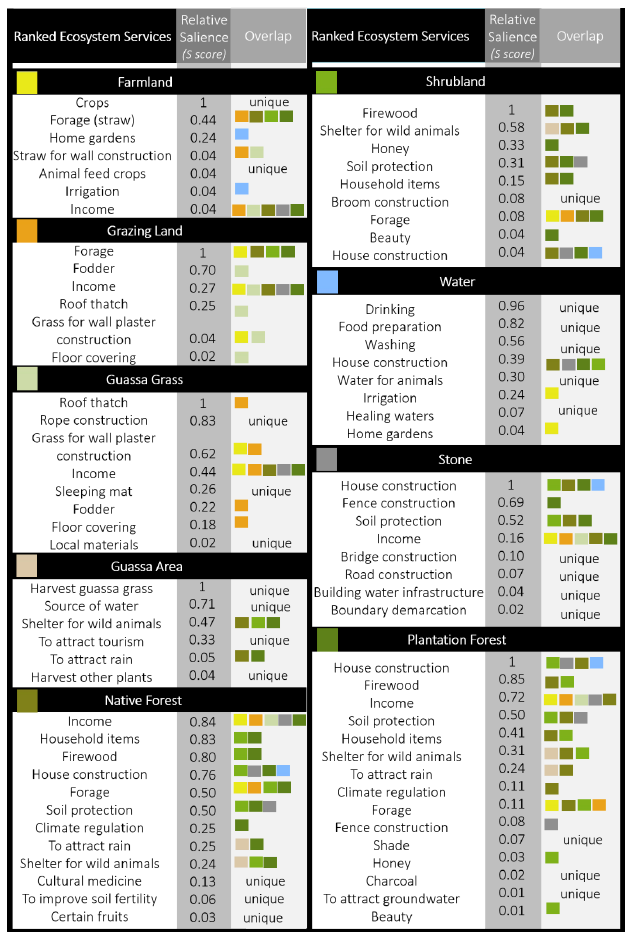
Fig. 4 . Locally defined land classes and their respective ecosystem services, ranked and aggregated across the nine kebeles. Colored squares indicate overlap of services with other land